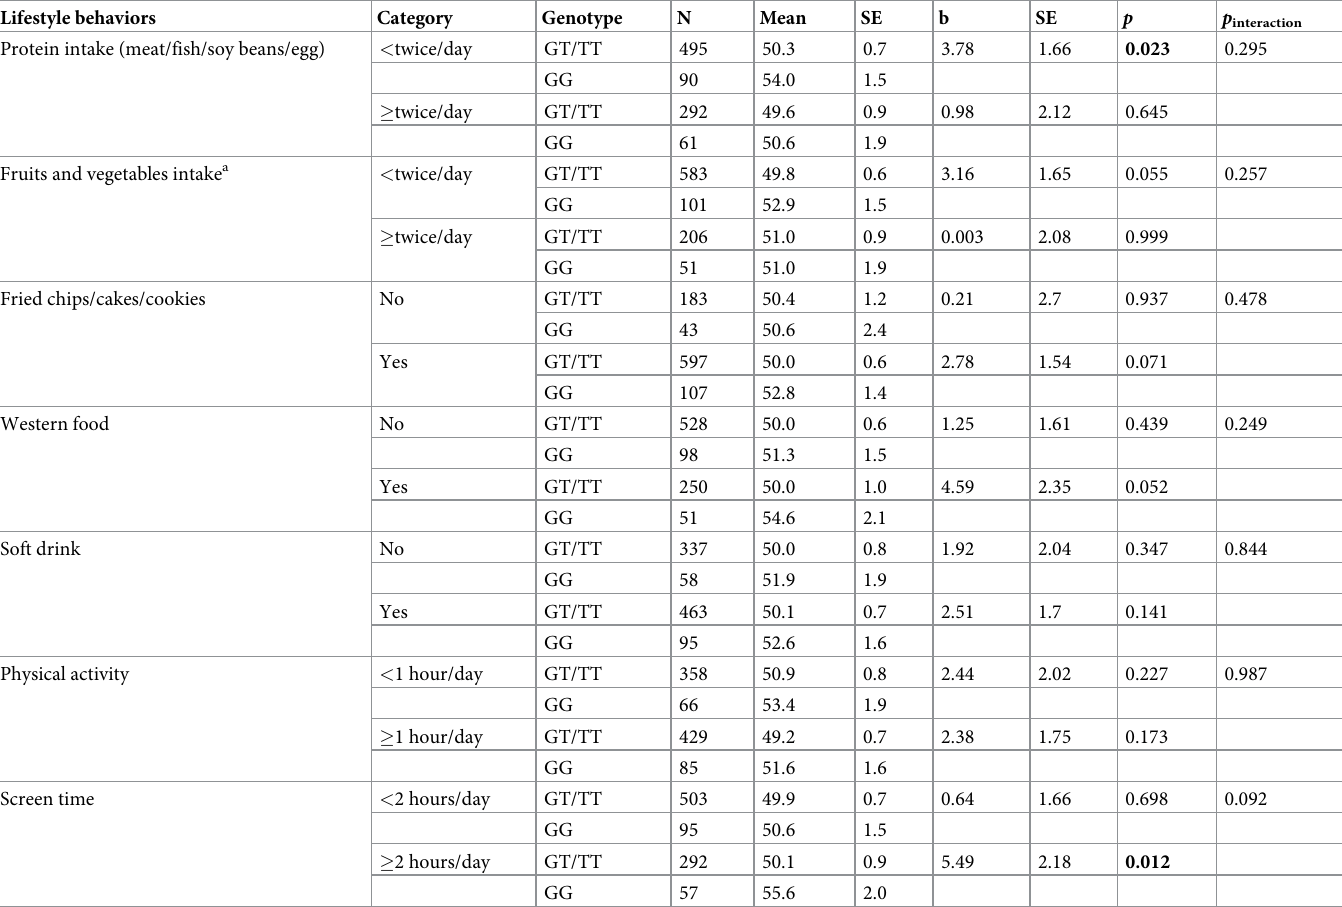
Table 3. Interaction between lifestyle behaviors and the CACNA1D rs9810888 polymorphism on DBP. Lifestyle behaviors